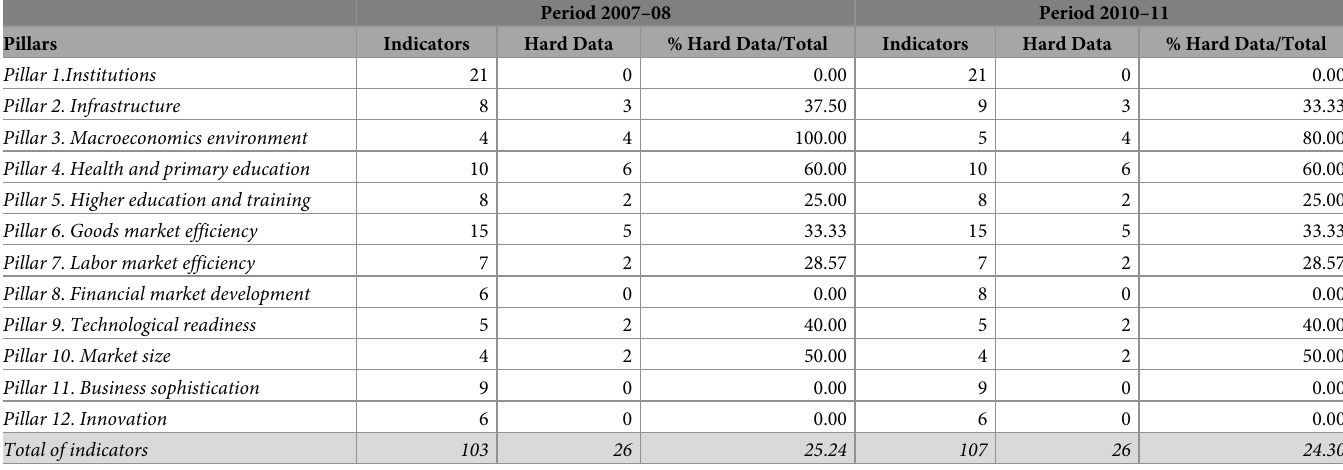
Table 2. Number of indicators in each pillar and percentage of hard